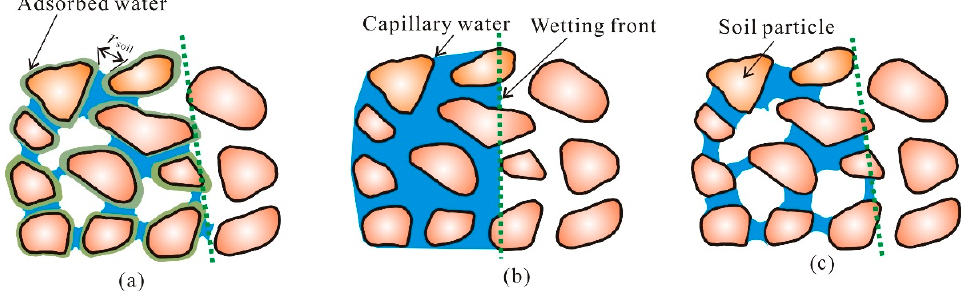
Figure 2. Water in an unsaturated soil: ( a ) actual soil moisture distribution introduced by Hillel [36] after a wetting front; ( b ) soil moisture distribution described by the GA model; and ( c ) soil moisture distribution described by the MGA model.